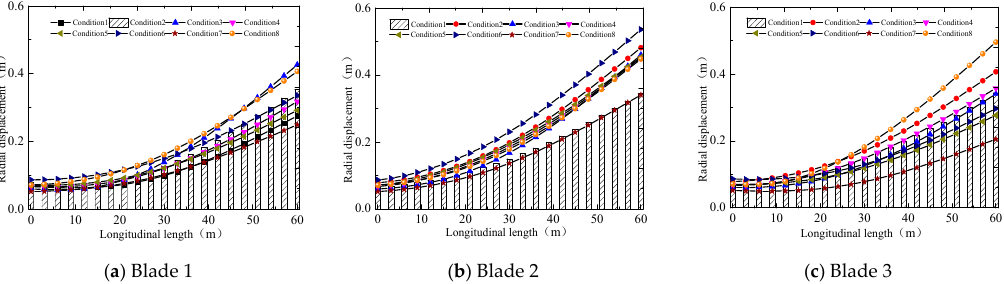
Figure 27. Distributions of RMS of downwind displacement of blade under different conditions.